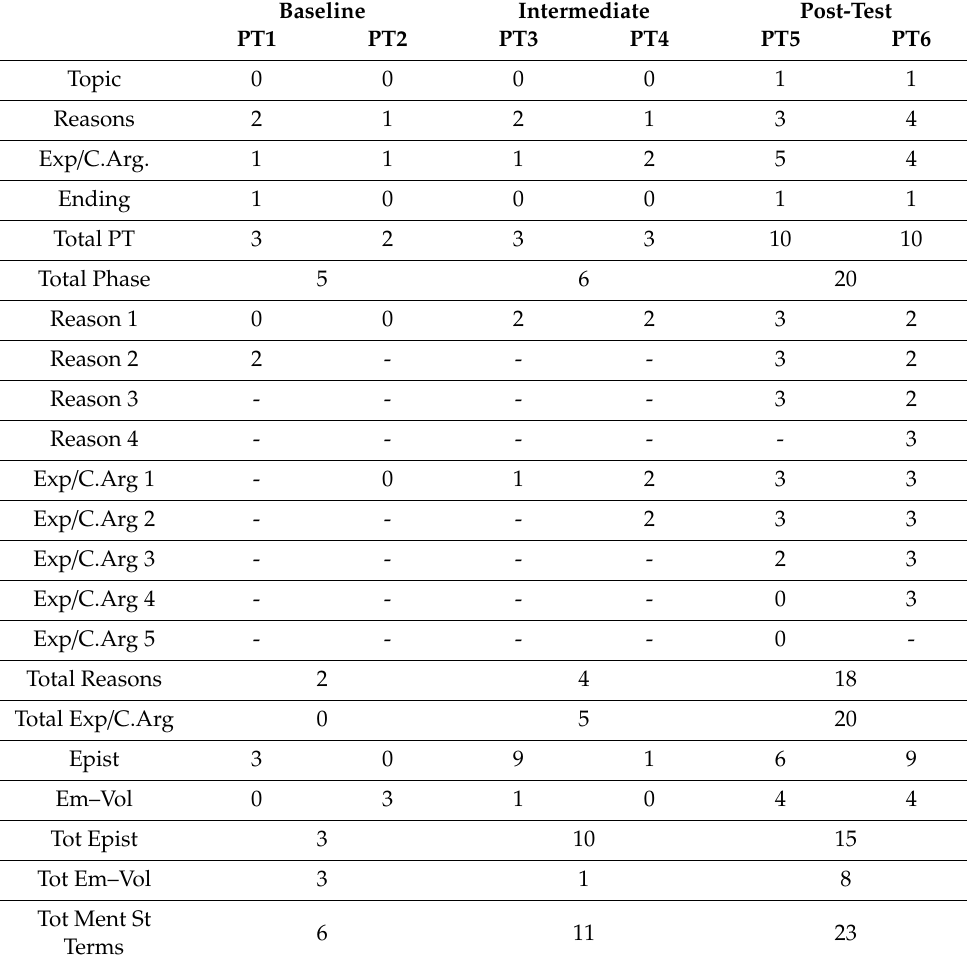
Table 1. Scores of all the measures in G’s persuasive texts (PTs) in all